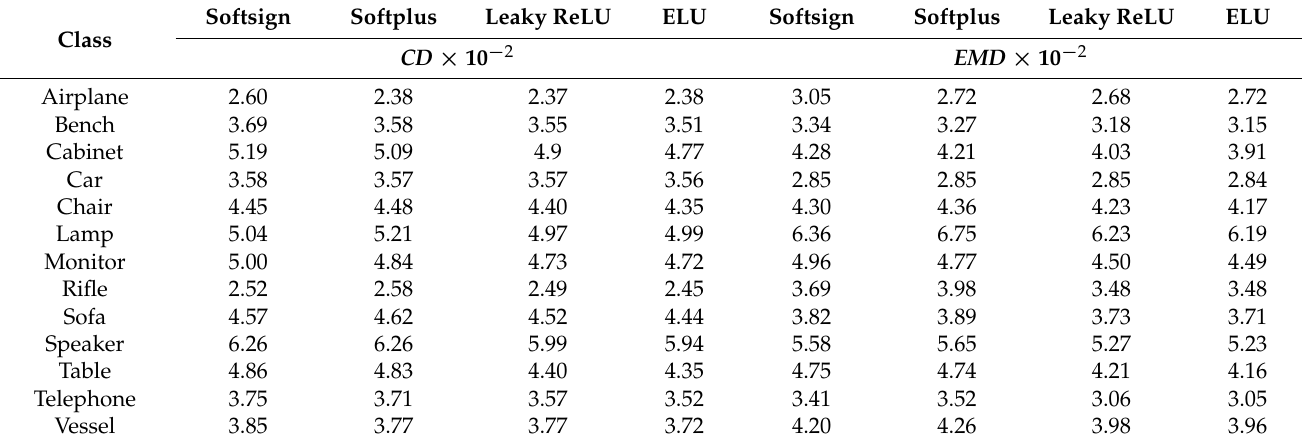
Table 2. Reconstruction results of different activation functions on ShapeNet dataset.